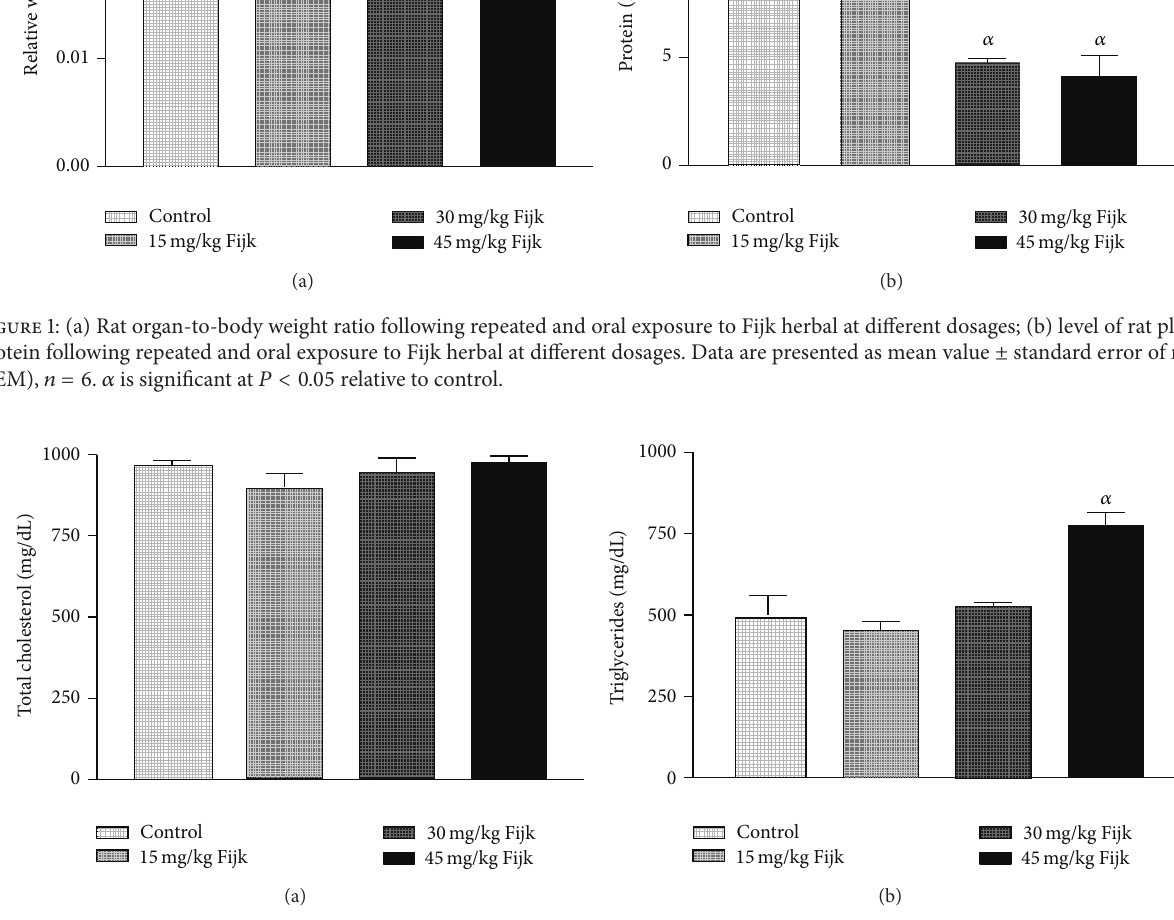
Figure 2: (a) Level of rat plasma total cholesterol following repeated and oral exposure to Fijk herbal at different dosages; (b) level of rat plasma triglyceride following repeated and oral exposure to Fijk herbal at different dosages. Data are presented as mean value ± standard error of mean (SEM), 𝑛 = 6 . 𝛼 is significant at 𝑃 < 0.05 relative to